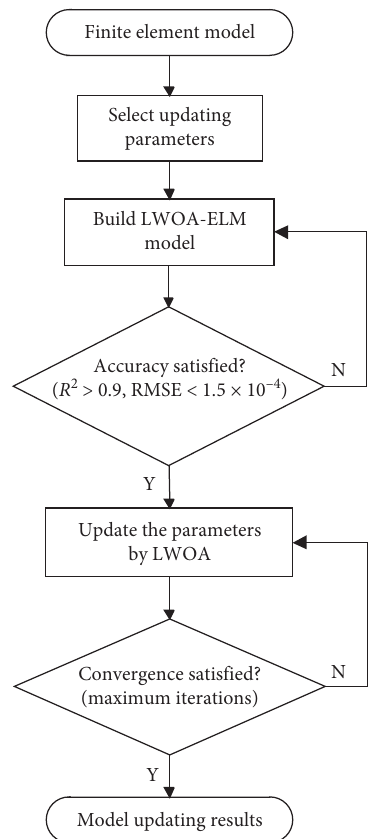
Figure 2: Flowchart of model